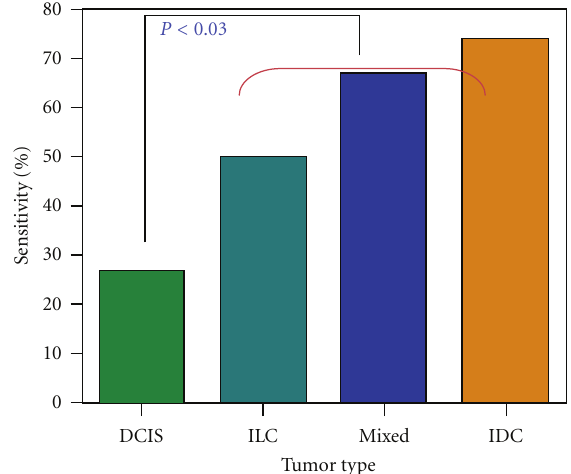
Figure 4: Plot of tCho concentration versus tumor type. The tCho concentration level was measured from 65 true-positive lesions, and the range was from 0.08–9.99 (mean ± SD, 2.7 ± 2.3mmol/kg), consistent with the previously published value. The mean tCho levels were IDC = 2.49, ILC = 2.70, mixed = 3.92, and DCIS = 1.57mmol/kg. The mean tCho levels were found to be higher in invasive cancer compared to noninvasive cancer, possibly associated with more aggressive behavior or faster cell replication in invasive cancer.